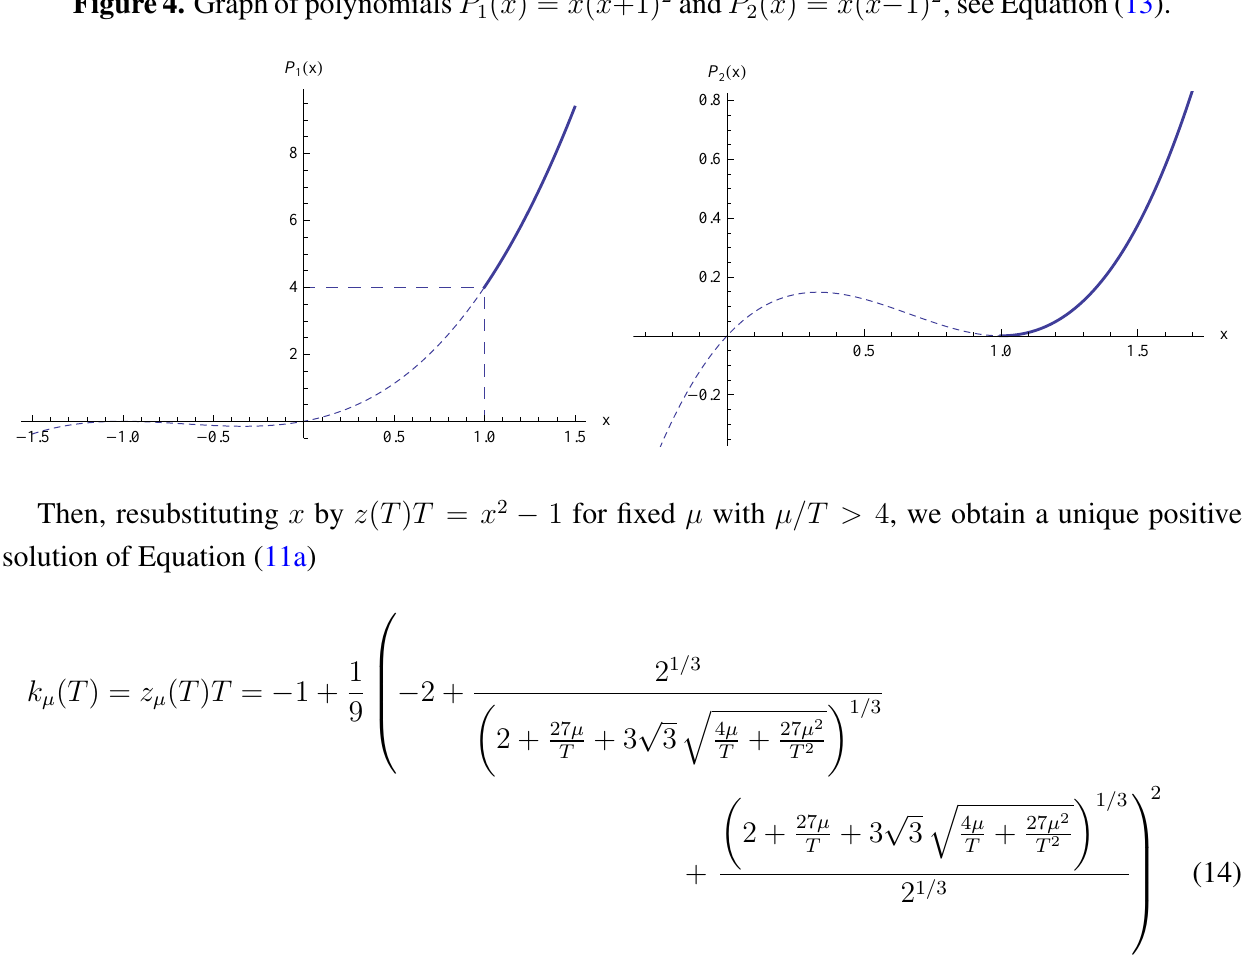
Figure 4. Graph of polynomials P